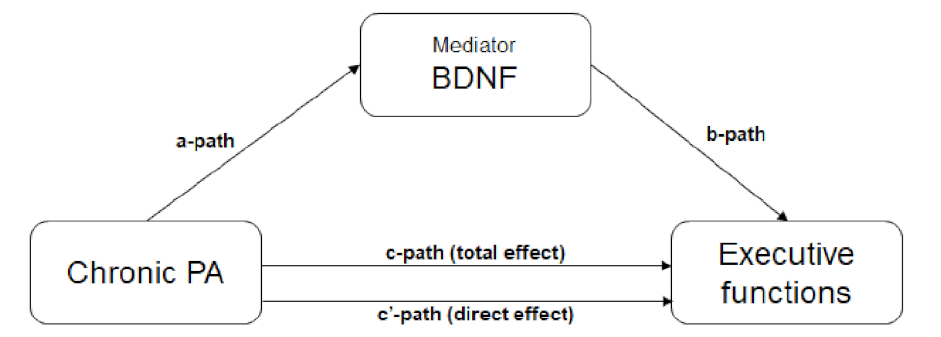
Figure 3. The mediation effect of chronic PA on EFs through BDNF levels.